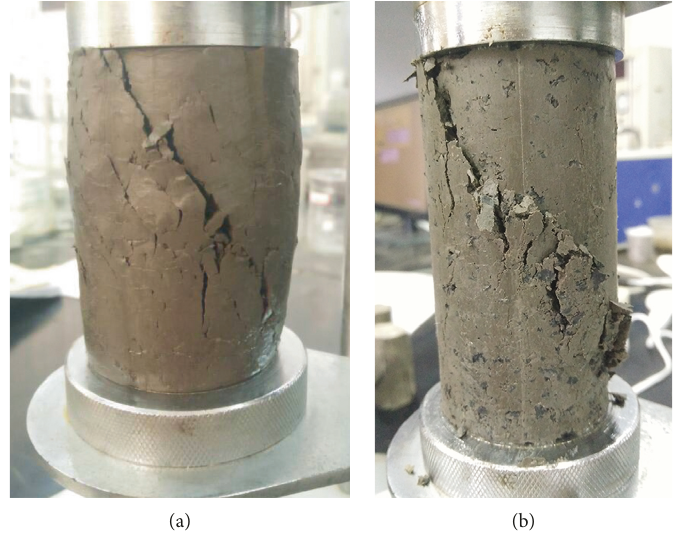
Figure 16: Inclined plane failure of (a) clayey soil and (b) mixture with C